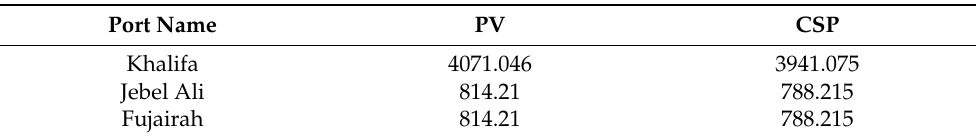
Figure 13. Comparison between the amounts of produced H 2 in the two location pathways with new proposed routes.